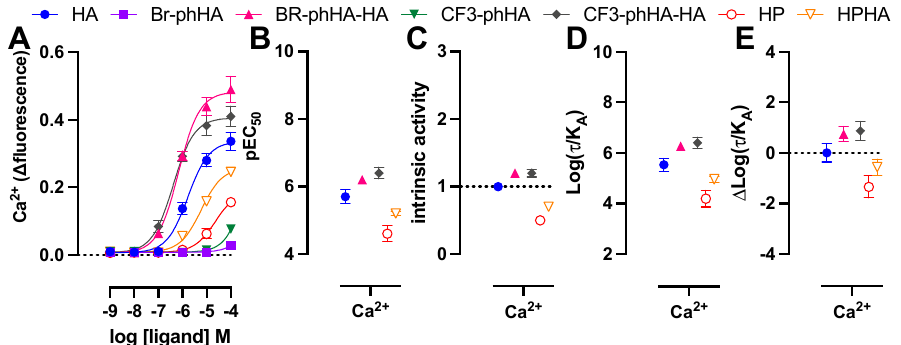
Figure 7. Activities of agonists in endogenous H 1 R-mediated Ca 2+ response in HeLa cells. Concen- tration response curves of Ca 2+ mobilization measured 20–30 s after stimulation of HeLa cells with agonists ( A ). The pEC 50 ( B ), intrinsic activity ( C ), transduction ratio (Log( τ /K A ) ( D ), and relative effectiveness ( ∆ Log( τ /K A ) as compared to reference agonist histamine ( E ) of agonist-induced Ca 2+ mo- bilization in HeLa cells are shown as mean ± SD from at least three independent experiments per- formed in triplicate.